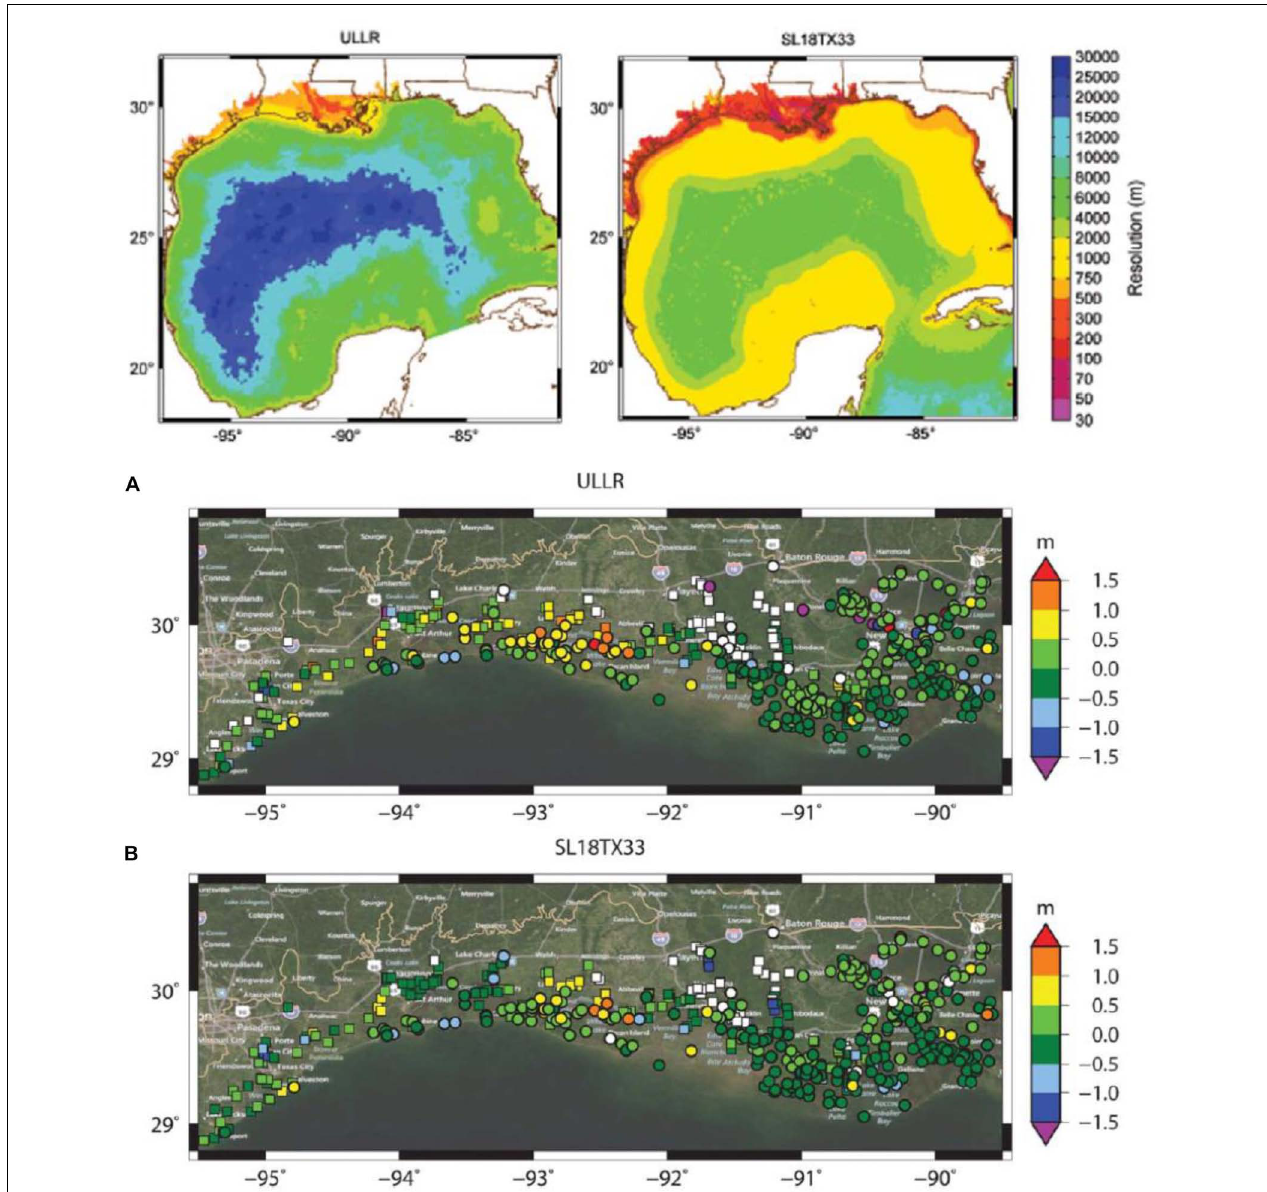
FIGURE 6 | Top panels represent grid resolution in meters of two different model configurations for the Gulf of Mexico (lower resolution labeled ULLR; higher resolution labeled SL18TX33). Locations of Hurricane Ike peak water levels along the northwest Gulf Coast simulated by (A) ULLR and (B) SL18TX33 (circles), and measured by hydrographs (squares). The points are color-coded to show the errors between measured and modeled peak water levels. Green points indicate matches within 0.5 m and white points indicate locations that were never wetted by the model. Adapted with permission from Kerr et al.